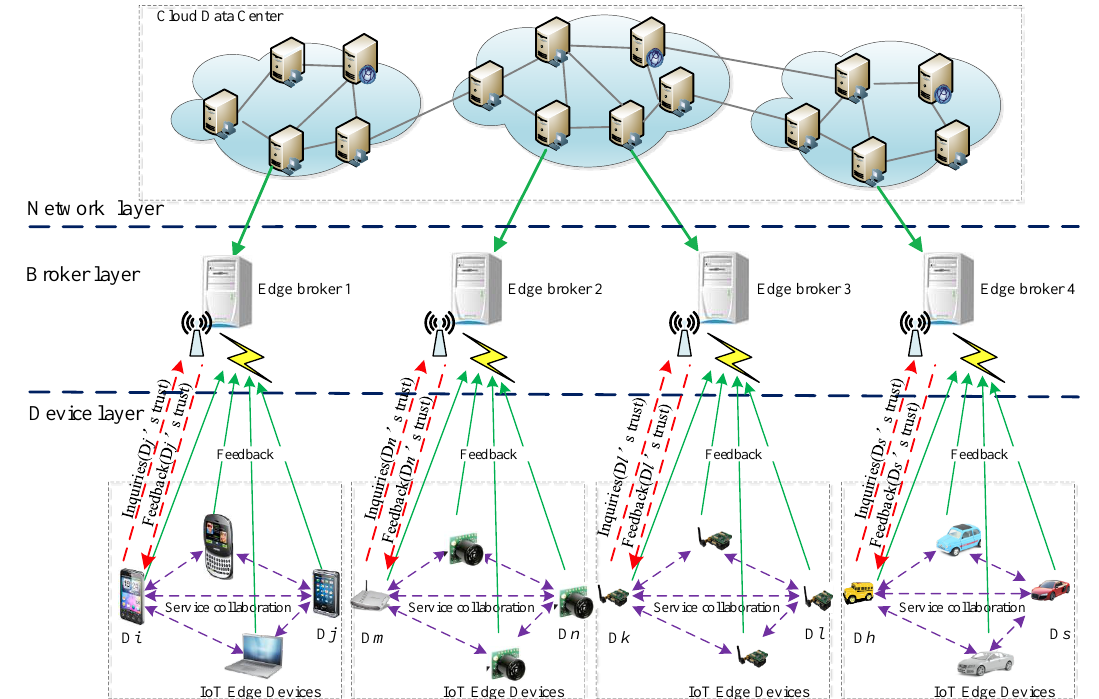
Figure 2. Trustworthy D2D cooperative mechanism in the mobile edge computing (MEC) architecture with the cloud